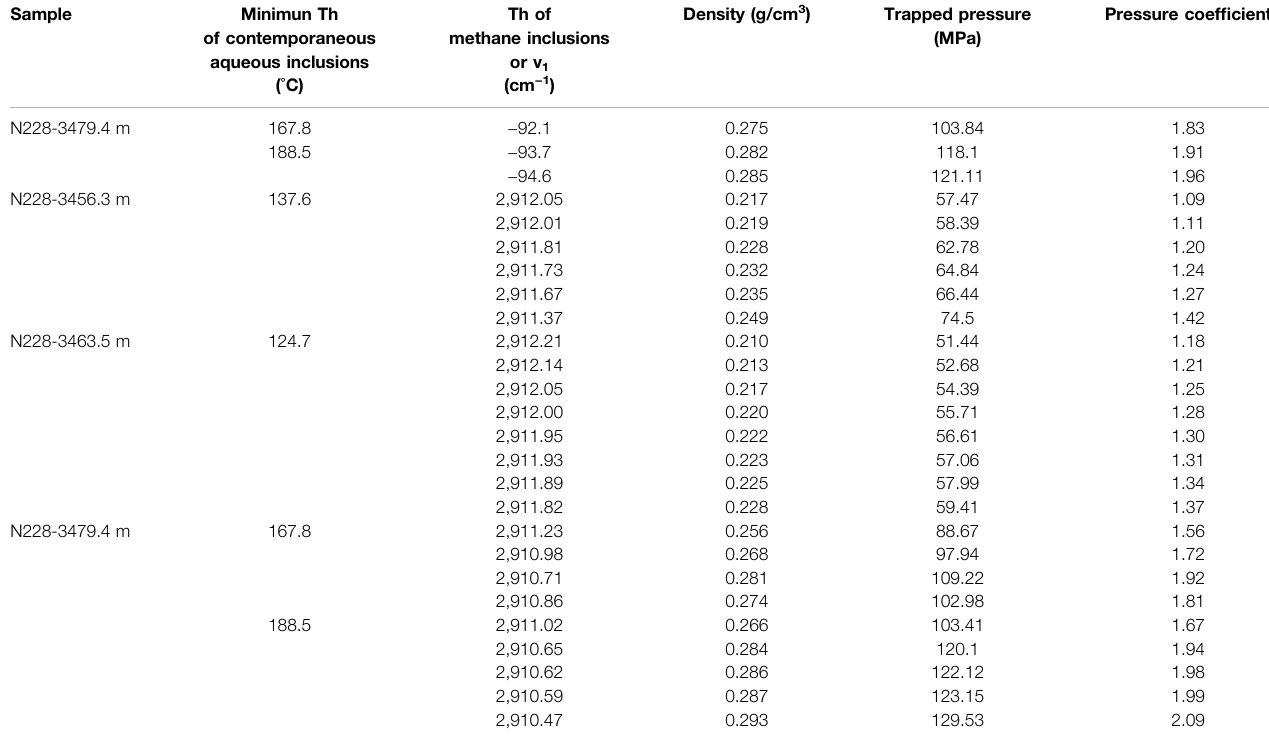
TABLE 2 | Density calculated by low-temperature method and Raman spectroscopy method, measured minimum Th of FIAs, corresponding pressure, and pressure coef fi cient of methane inclusions in samples N228-345.3 m, N228-3463.5 m, and N228-3479.4 m. Sample Minimun Th of